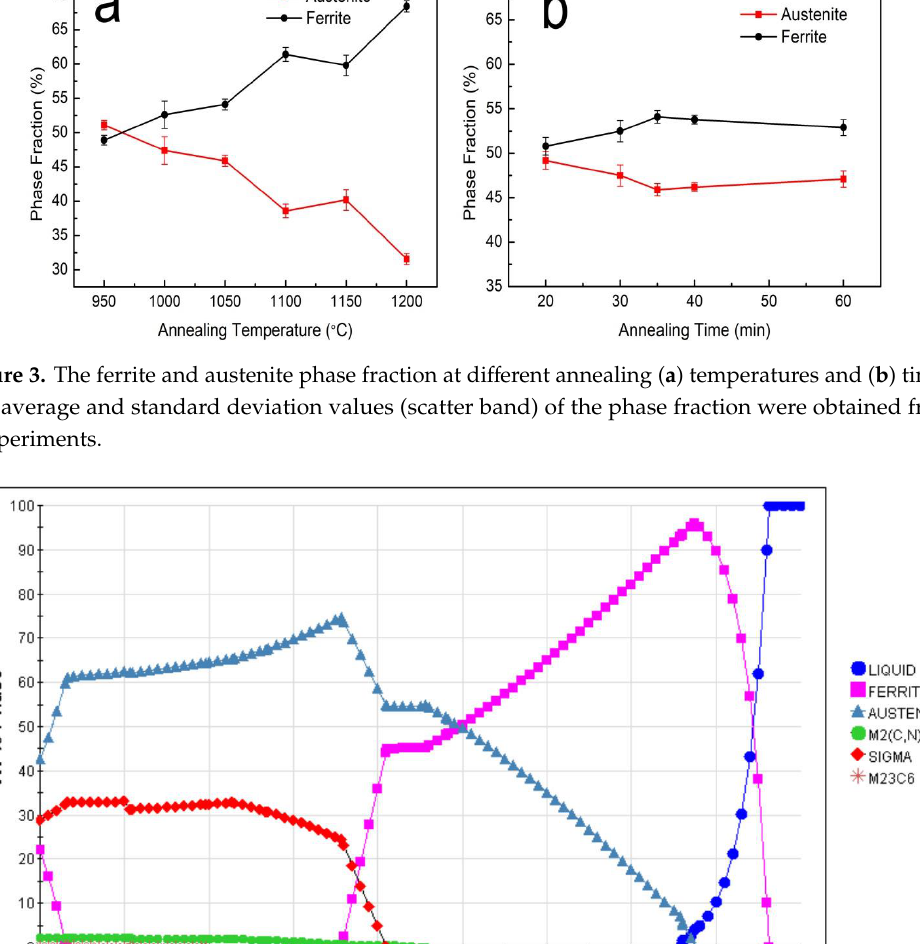
Figure 4. Equilibrium phase diagram of the S32750 stainless steel calculated using JMatPro software (Sente Software Ltd., Guildford, England).